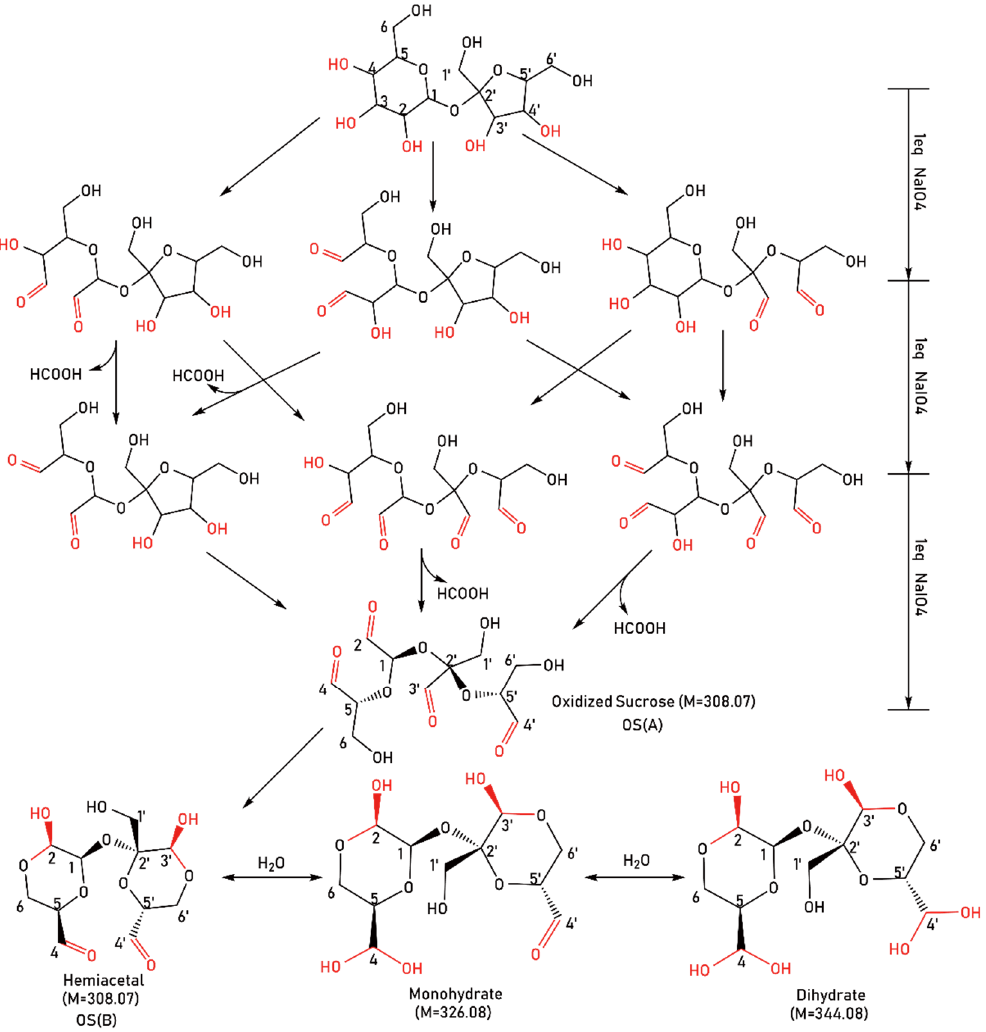
Figure 1. Reaction pathways for oxidized sucrose preparation.